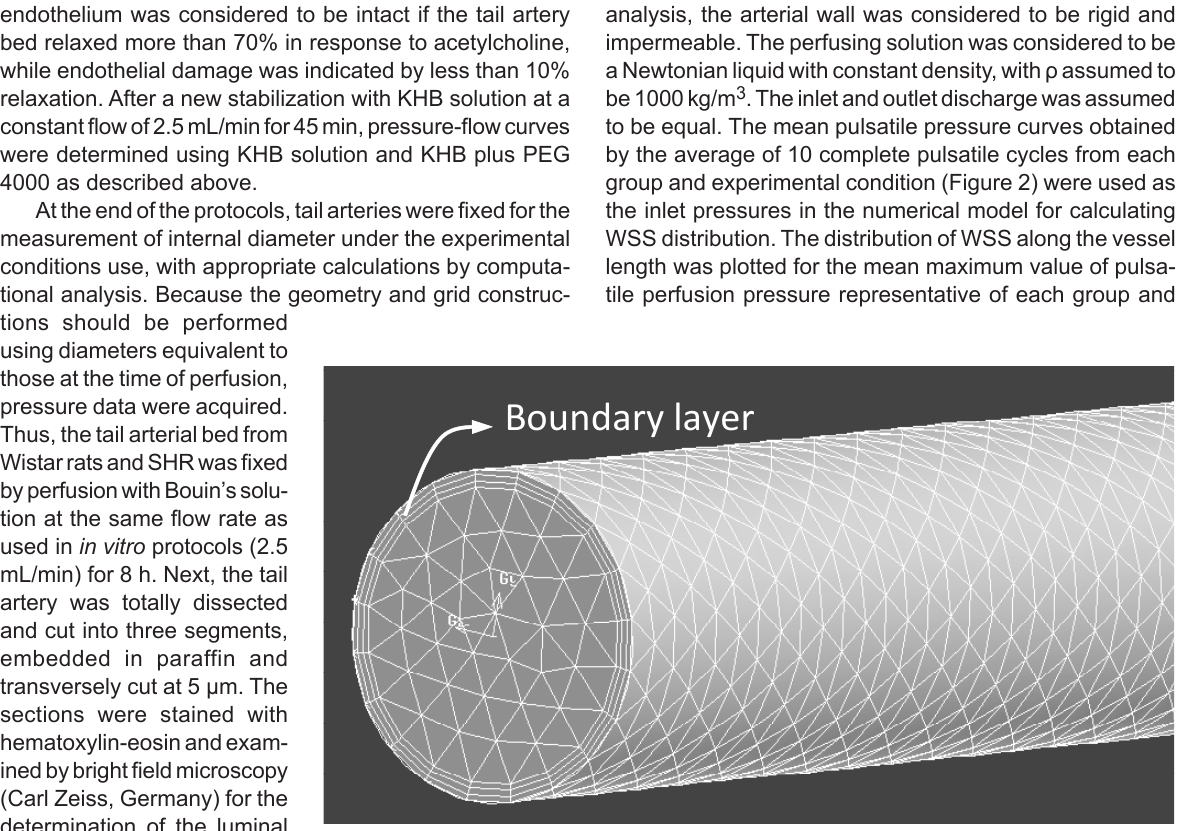
Figure 1. Unstructured grid of the tail artery with a boundary